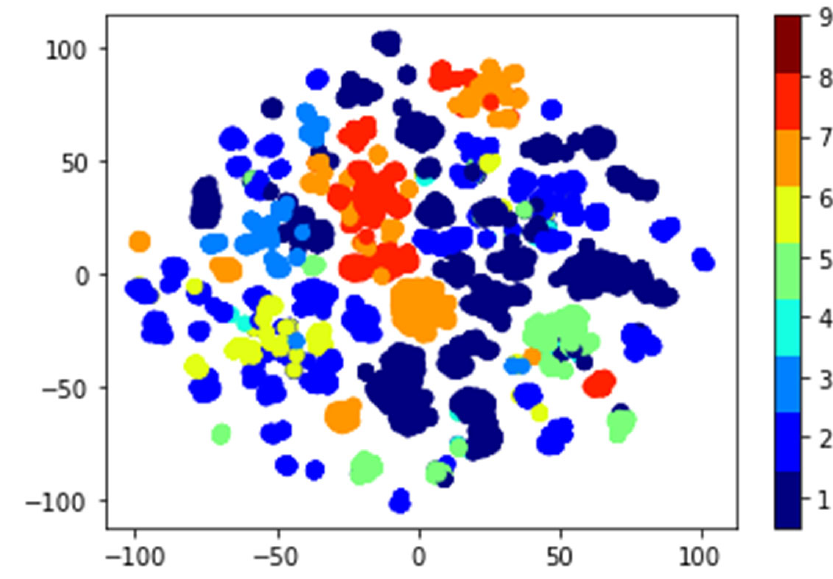
Figure 4. Dataset t-SNE 2D visualization.